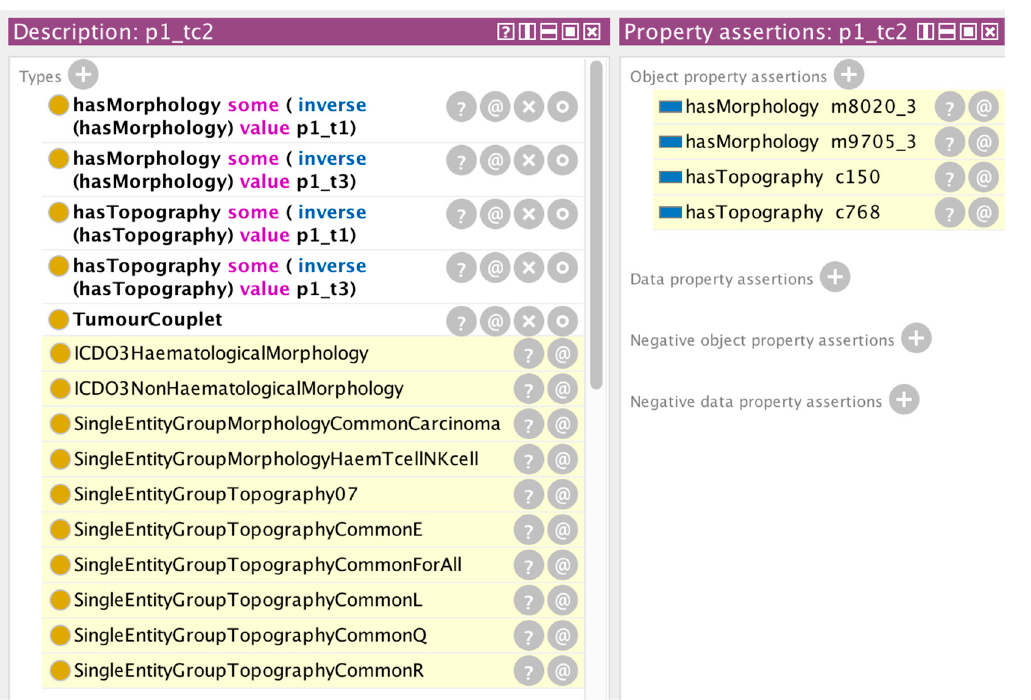
Figure 3. Results of the reasoning operation for the tumour couplet p1_tc1. Only the topography codes are equivalent (classified under DuplicateTopographyGroup) and the couplet is a valid MPT.